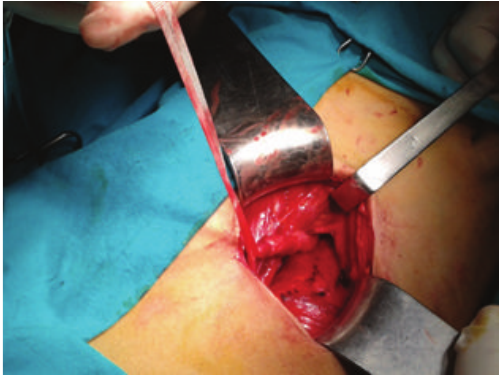
Figure 3: The origin of stalk at the level of iliac bifurcation.